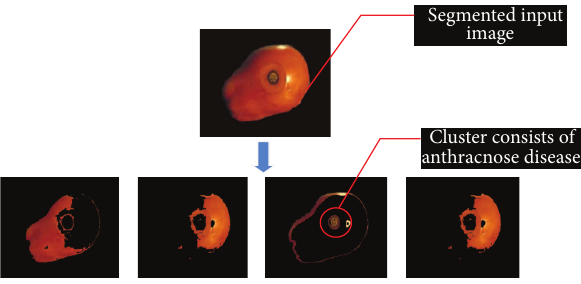
Figure 5: Extracted clusters using proposed